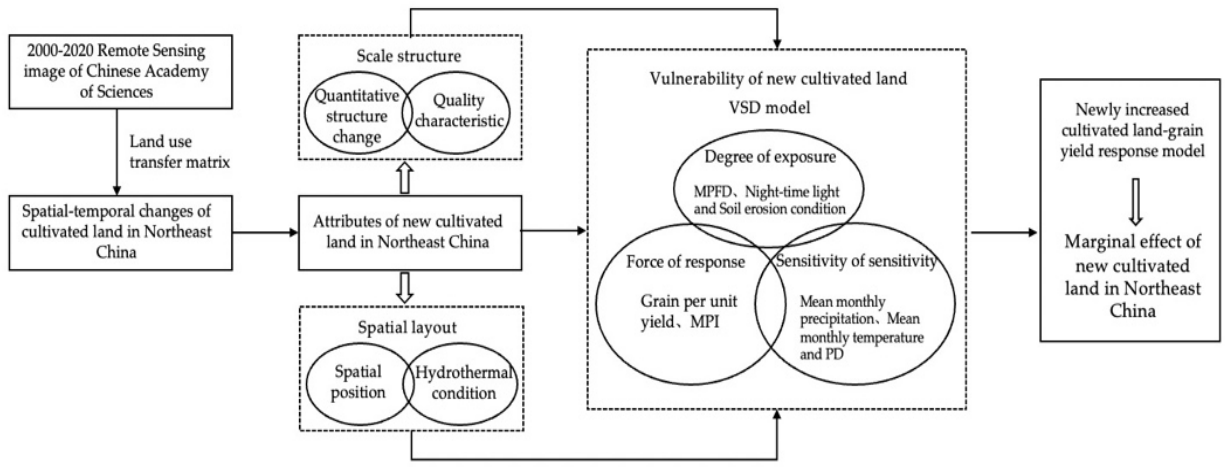
Figure 2. Study fl ow chart . Figure 2. Study flow